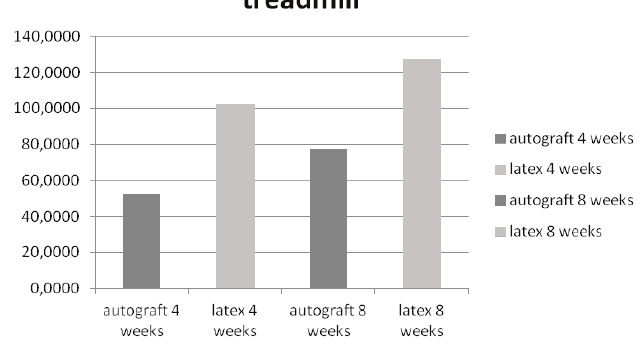
FIGURE 2 - Histogram showing the results of computerized treadmill analysis. FCI (functional capacity index) around 100 is considered a good performance. Rats transplanted with latex conduits presented higher FCI of operated hind leg than rats transplanted with autologous nerve